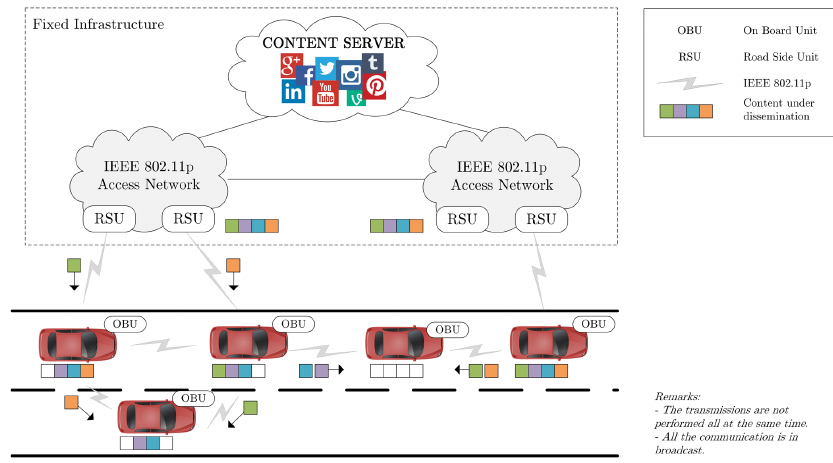
Figure 1. Content distribution to-be scenario